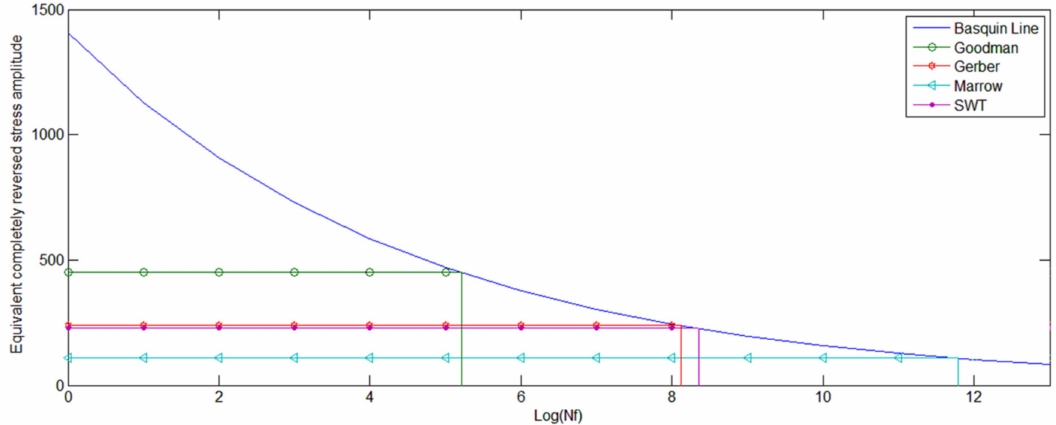
Figure 17. Plot of σ ar (principal stress)-Log (N f ) for different theories describing the